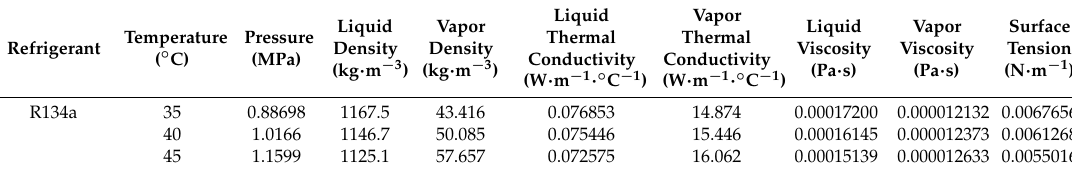
Figure 6. Comparisons of friction factor between experimental value and theoretical value for a single-phase flow. Table 4. Working conditions of the experiment. Table 3. Thermal-physical properties of R134a.